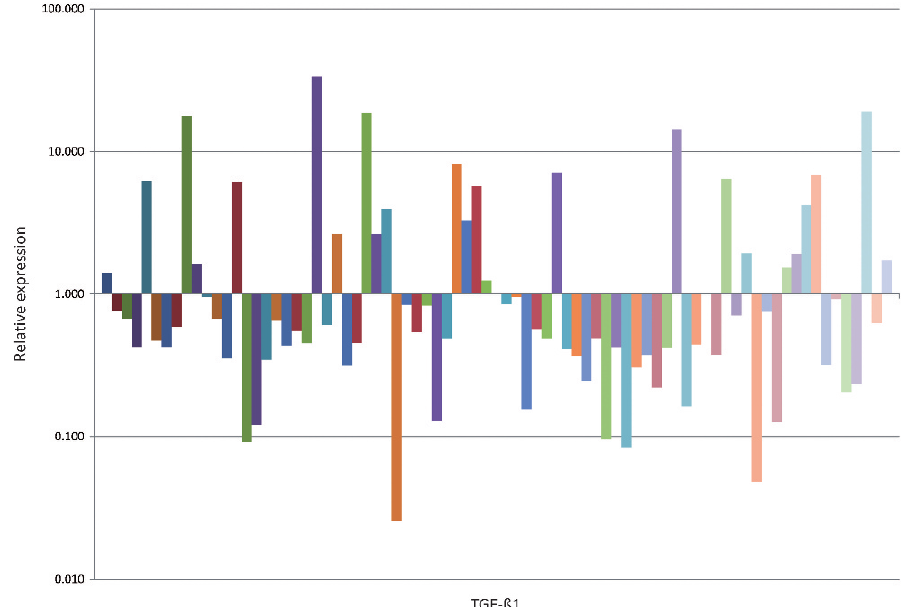
Figure 1 - Quantitative expression of TGF- b 1 messenger RNA in malignant prostatic tissue compared with BPH. Fold change in expression was calculated using the 2- DD CT method.